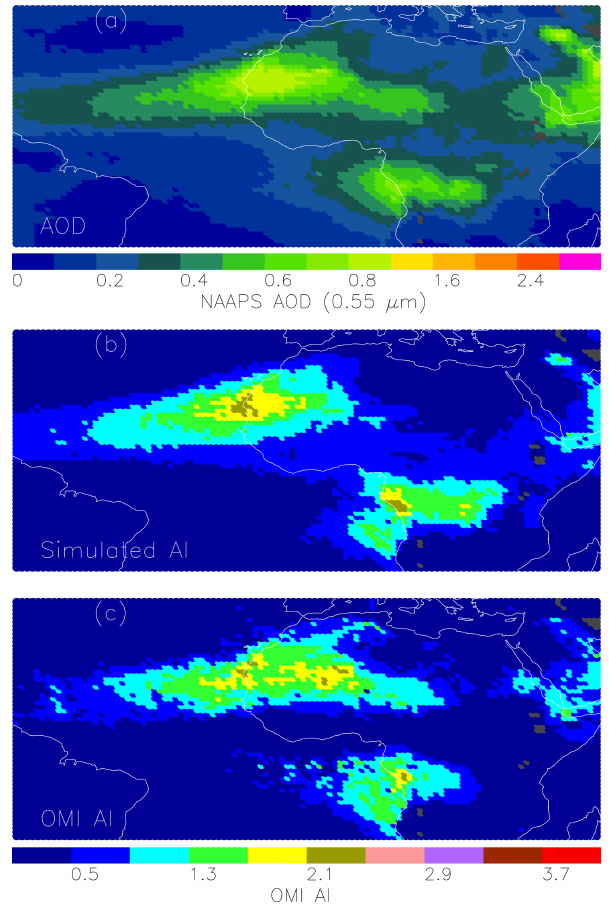
Figure 1. (a) Spatial distribution of NAAPS AODs using NAAPS reanalysis data from the collocated OMI and NAAPS dataset for July 2007. (b) Simulated AI using NAAPS reanalysis data as shown in (a) . (c) Spatial distribution of OMI AI using gridded OMI data from the collocated OMI and NAAPS dataset for July 2007. Grey highlights those 1 × 1 ◦ (latitude–longitude) bins that have fewer than three collocated NAAPS and OMI AI data points for the study pe-